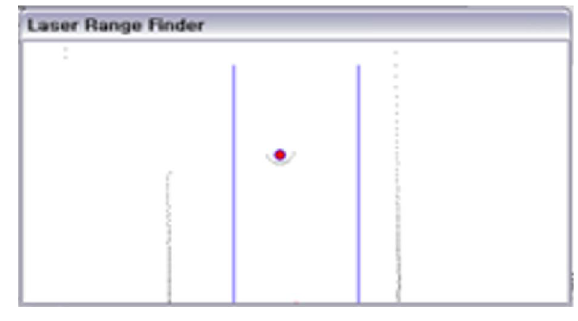
FIG. 15. RANGE OF OBSTACLES IN LRF COMPUTER SIMULATION